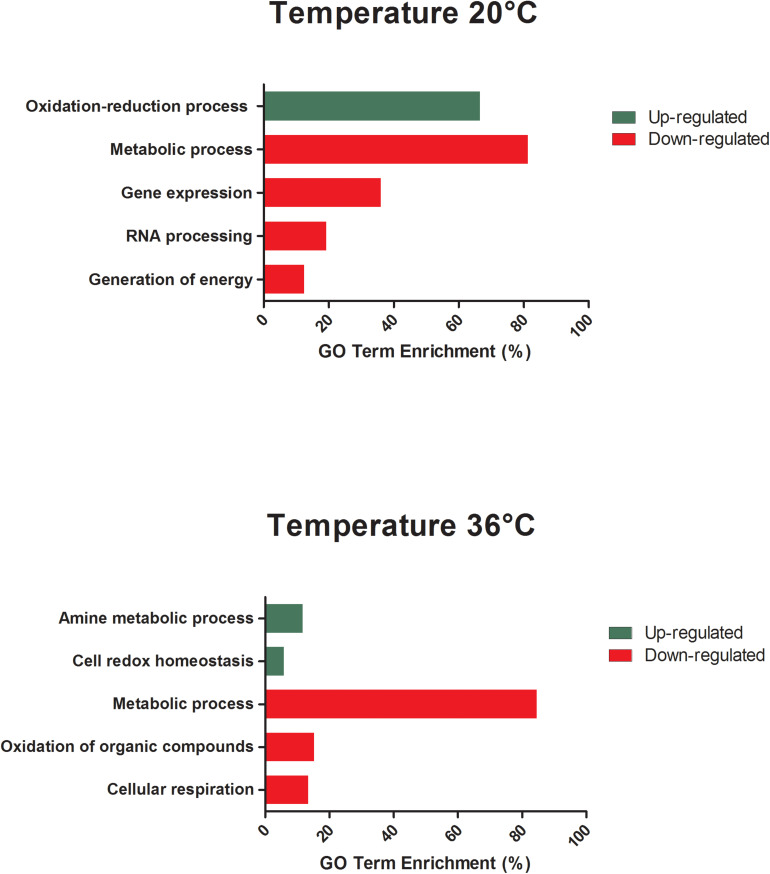
GO term enrichment analysis of differentially expressed genes of unexposed Aedes aegypti kept under the lowest (20°C) and the highest (36°C) temperature conditions in the category of biological processes for up- and down-regulated genes at 48 h.